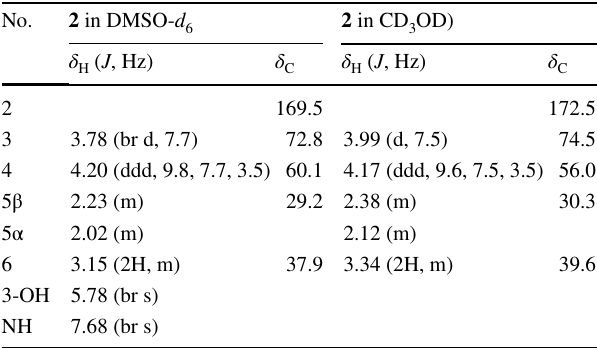
Table 2 1 H (500 MHz) and 13 C NMR (126 MHz) data of 2 No.